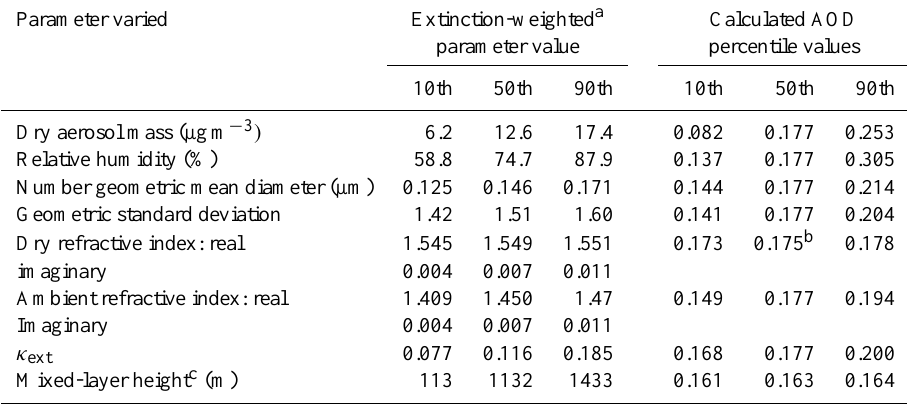
Table 1. AOD calculated from sensitivity tests. Parameter